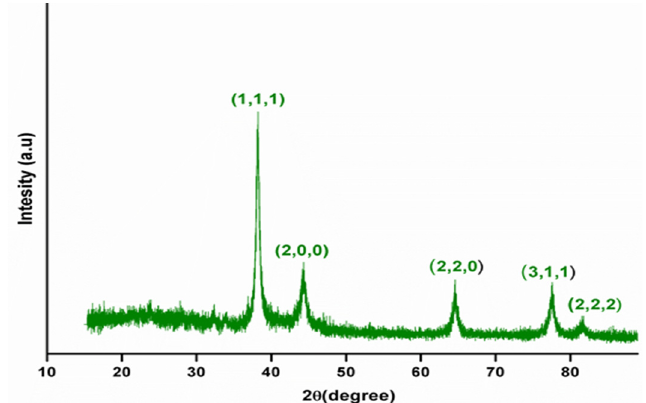
Figure 1. X-ray diffraction patterns of green synthesized silver nanoparticles (AgNPs) using M. frondosa leaf extract.